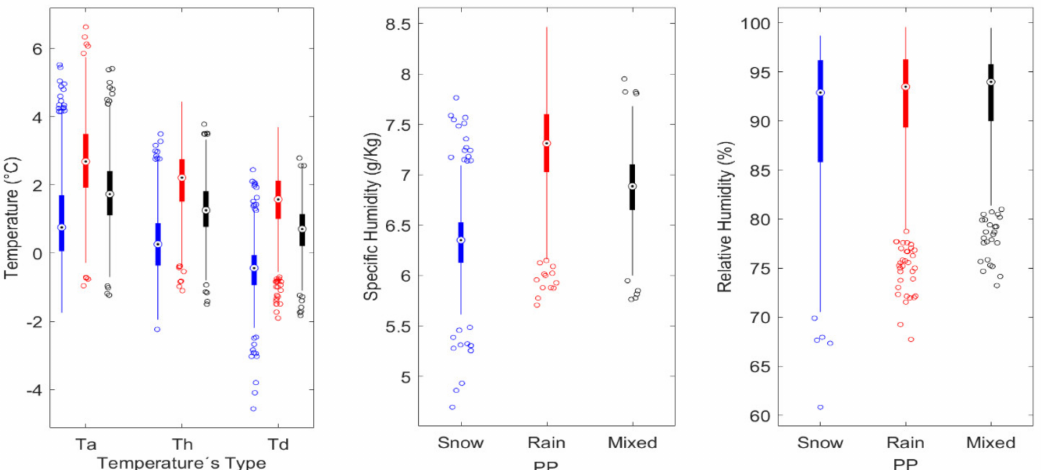
Figure 10. Boxplots of Ta, Th, and Td are shown for solid, liquid, and mixed precipitation (blue, red, black) ( left ). Boxplots of specific humidity are shown for snow, rain, and mixed precipitation (blue, red, black) ( center ). Boxplots of relative humidity are shown for snow, rain, and mixed precipitation (blue, red, black) ( right ).